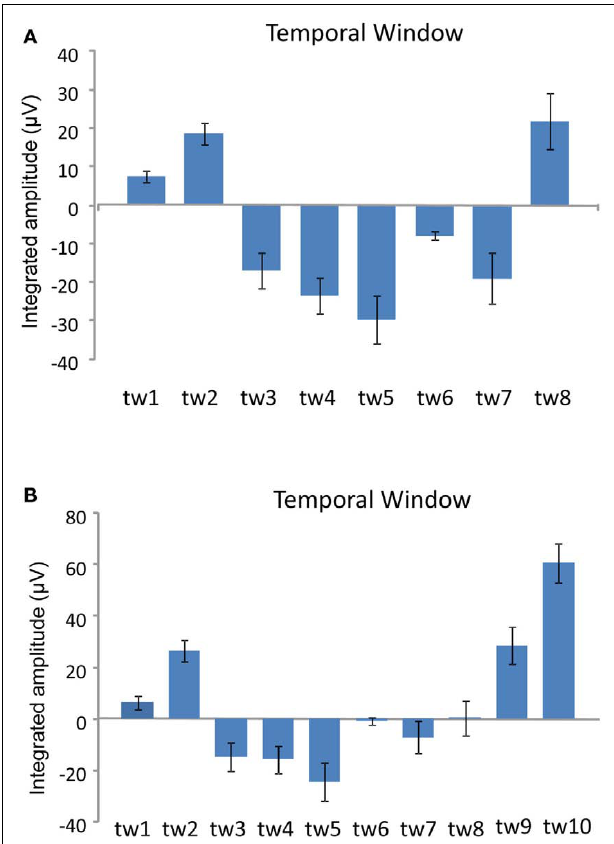
FIGURE 5 |The multiple comparisons among temporal windows on the mean CNV amplitude averaged between Pay attention and Ignore conditions calculated over successive temporal windows (tw) on the averaged activity of the six prefrontal electrodes (FP1, FP2, F3, F4, Fpz, and Fz). (A) 600ms condition, and (B) 800ms condition, respectively.The CNV appeared between tw3 and tw7, in the 600-ms condition, tw3 and tw8 in the 800-ms condition, which approximately corresponded to the interval between the first sound and the second